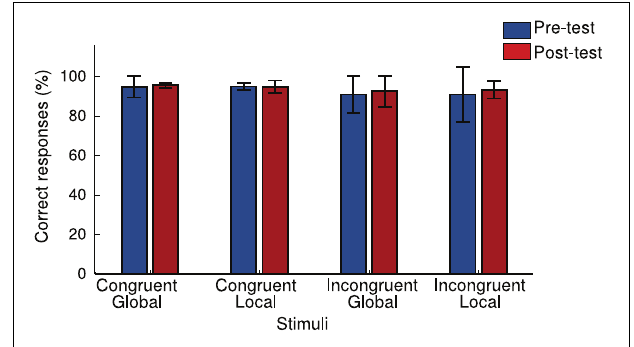
FIGURE 4 | Mean correct responses to the local and the global task in congruent and incongruent condition at pre-test and